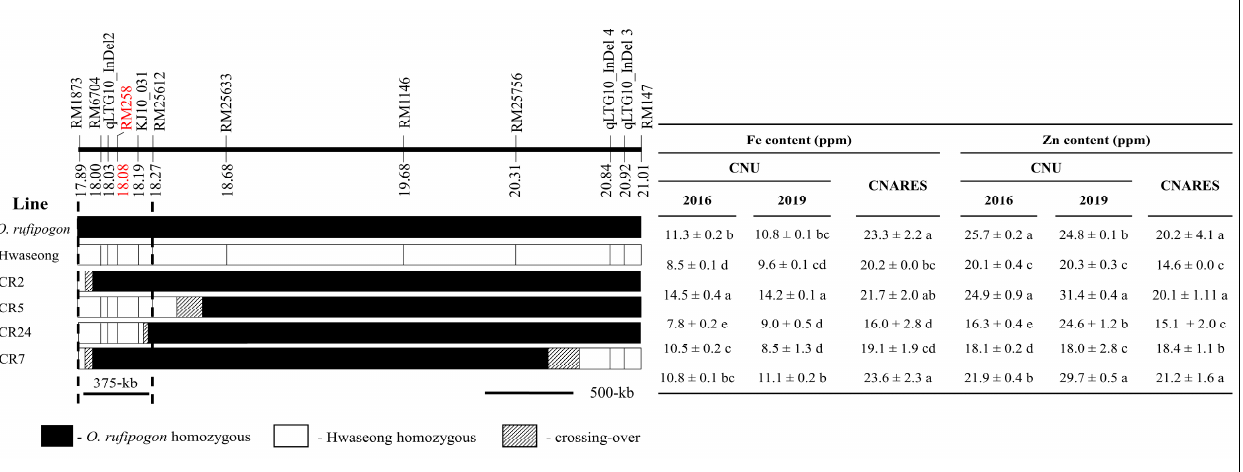
Means in each column with different letters are significantly different from each other at p = 0.05 based on Tukey’s test. Error bars represent the ± standard deviation of the mean. All values repre- sent the mean of three replicates. Table 4. Zinc content in root and shoot of rice genotypes grown under -Zn and +Zn treatments.